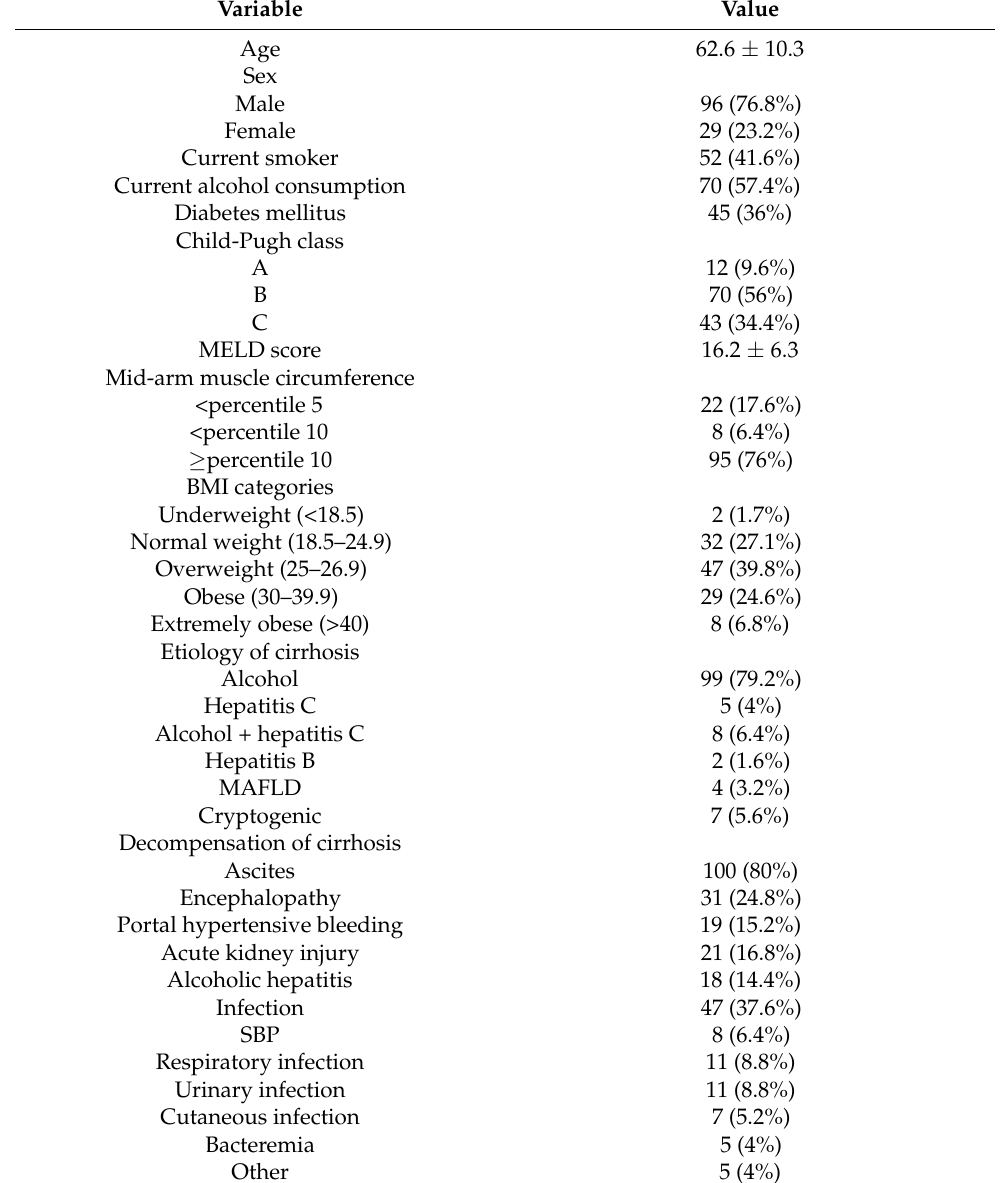
Table 1. Summary of baseline characteristics for all included